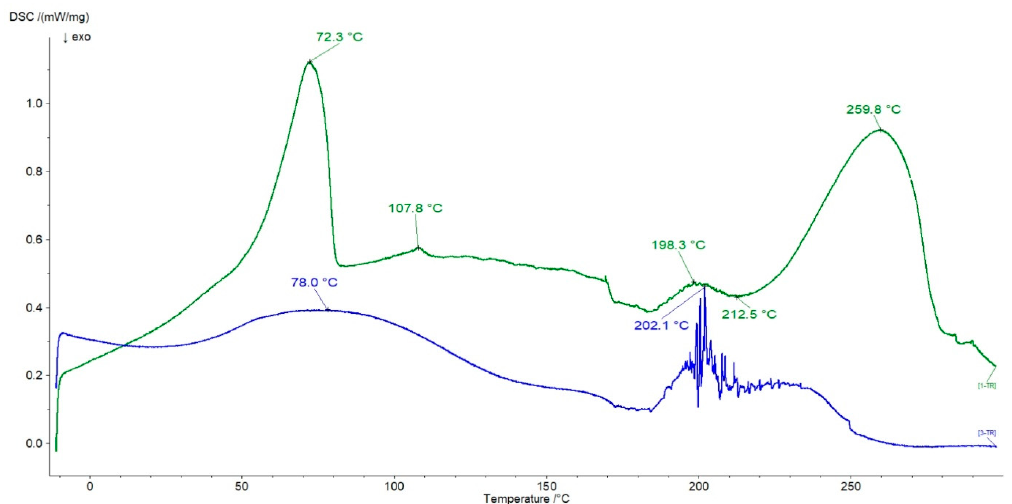
Figure 12. The thermograms of the physical mixture of HA + L (green line) and the formulation F4 (blue line).